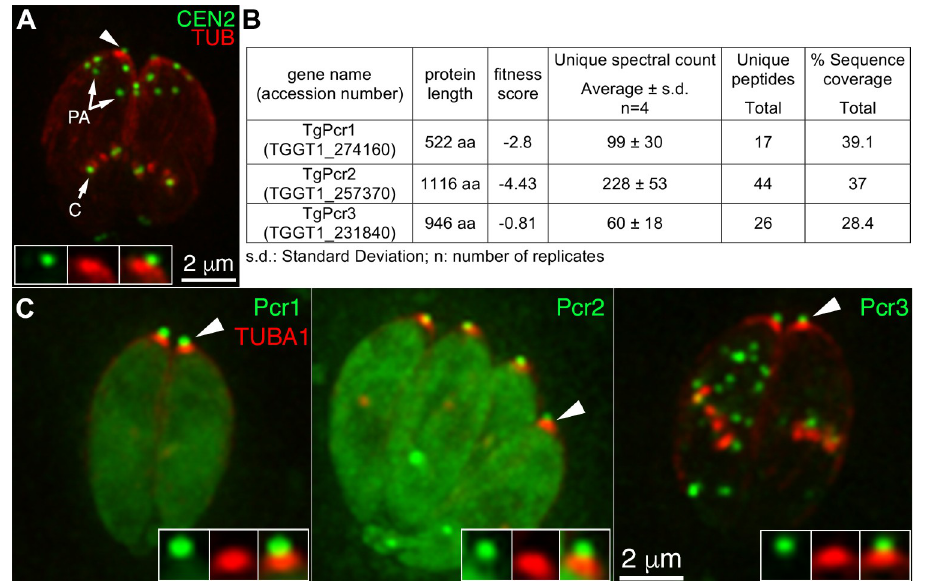
Fig 2. Identification of candidate apical complex proteins via immunoprecipitation using GFP-Trap and eGFP-CEN2 knock-in parasites. A. Deconvolved wide-field images of intracellular eGFP-CEN2 knock-in parasites [55] expressing mCherryFP tagged tubulin (red). Insets (shown at 2X) include the preconoidal region (arrowhead). PA: peripheral annuli; C: centrioles. B. Table showing the protein length, fitness score, average unique spectral counts, peptide counts, and sequence coverage for TGGT1_274160, TGGT1_257370, and TGGT1_231840, identified by MuDPIT in 4 replicates of immunoprecipitation using GFP-Trap and eGFP-CEN2 knock-in parasites. See S1 Table for the complete list of identified proteins. C. Deconvolved wide-field images of intracellular parasites expressing mCherryFP tagged tubulin (red) and mEmeraldFP (green) tagged Pcr1 (TGGT1_274160), Pcr2 (TGGT1_257370), or Pcr3 (TGGT1_231840) with expression driven by a T . gondii tubulin promoter. As predicted for preconoidal proteins, Pcr1, Pcr2, and Pcr3 are localized to a structure (green, insets) that is apical and smaller in diameter than the conoid (red, insets). Insets (shown at 2X) include the preconoidal region